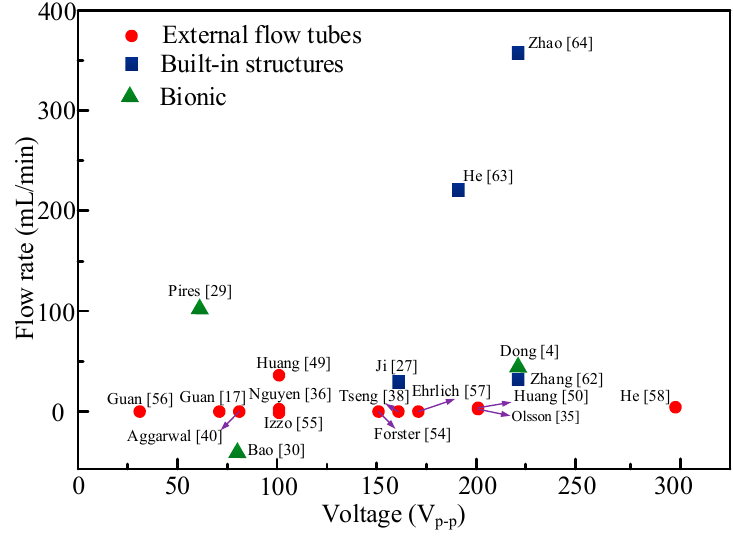
Figure 7. Maximum flow rates for valveless piezoelectric pump: flow rates versus voltages.